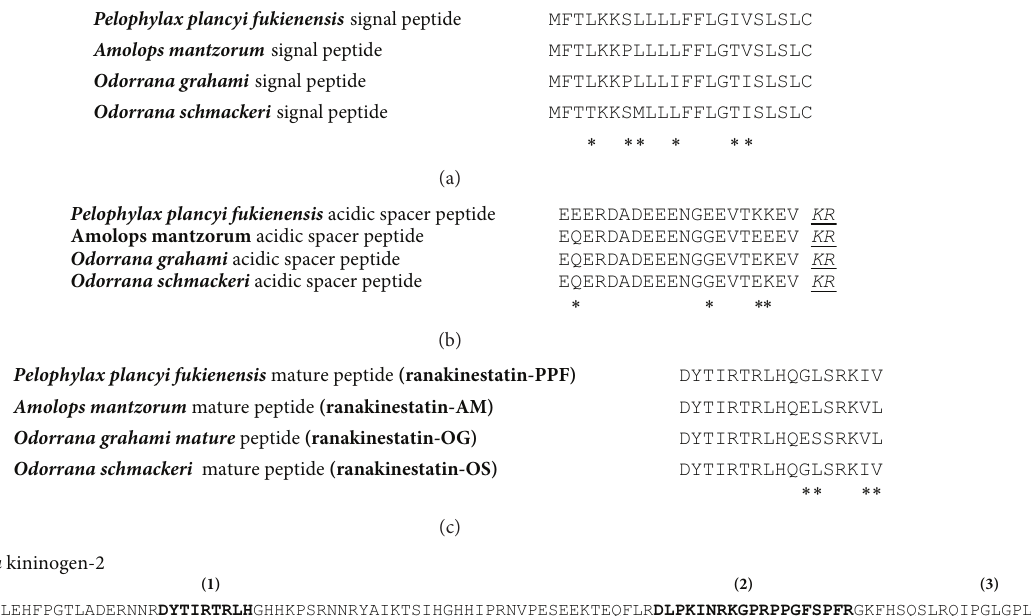
MRLWFCLSFFIVLCLEHFPGTLADERNNR DYTIRTRLH GHHKPSRNNRYAIKTSIHGHHIPRNVPESEEKTEQFLR DLPKINRKGPRPPGFSPFR GKFHSQSLRQIPGLGPLRG